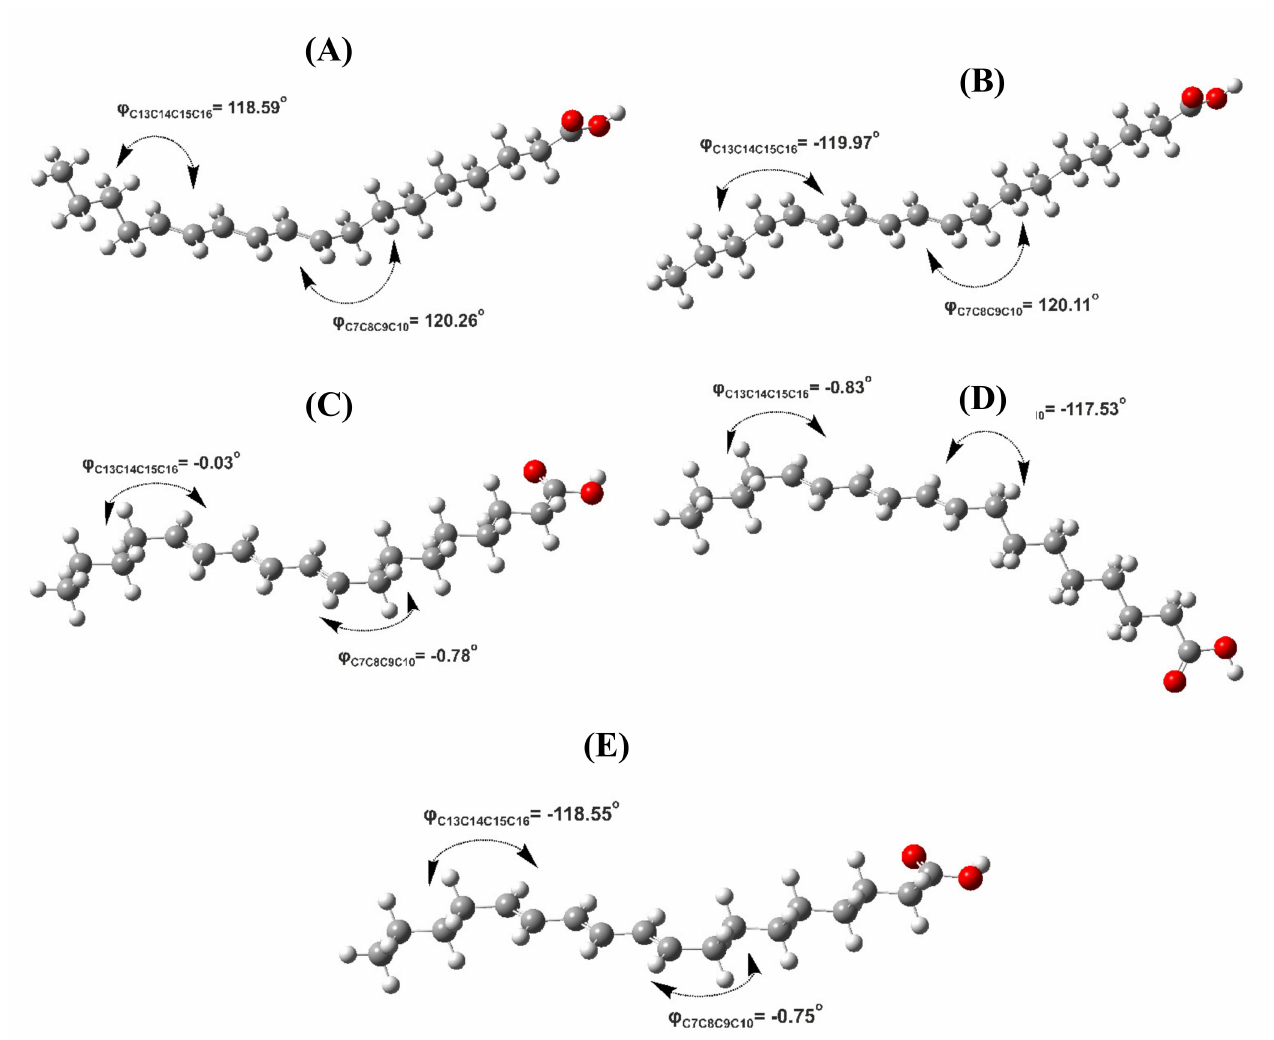
Figure 7. Structures of various conformers ( A – E ) of the β -eleostearic acid (9 E ,11 E ,13 E -isomer) with energy minimization in the gas phase at the B3LYP/6–31+G(d) level of theory. ∆ G values (kcal · mol − 1 ) and % populations of conformers ( A – E ) are shown in Table